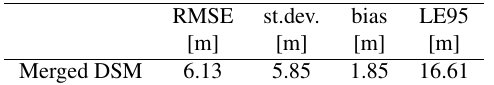
Table 4: Merged DSM assessment